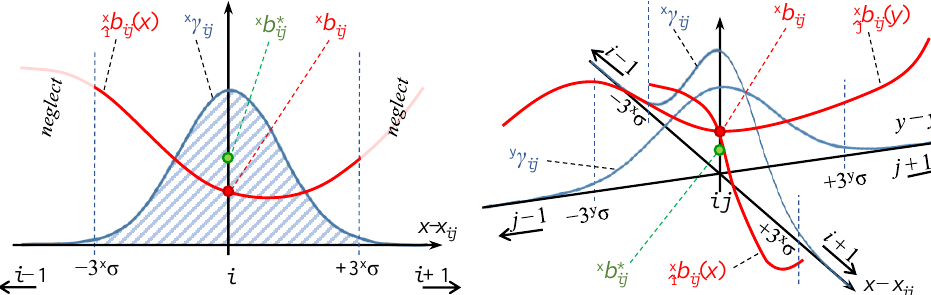
Figure 8. Representation of debiasing in 1D (left) and 2D (right).